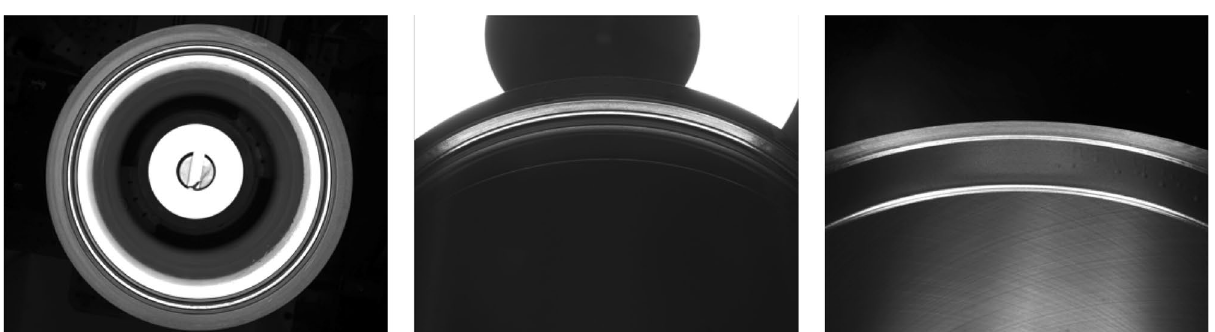
Figure 3. Three cylinder liner examples taken by an area-array CCD